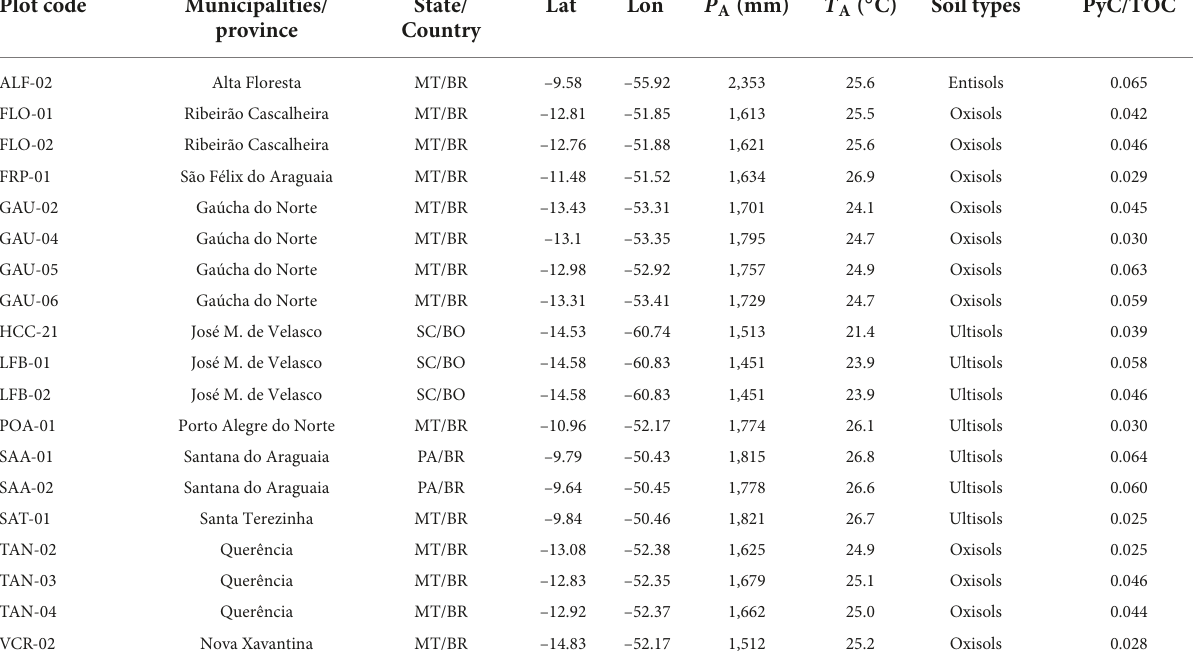
TABLE 1 Forest plot codes (RAINFOR codes), states (MT, Mato Grosso; PA, Pará; SC, Santa Cruz province), Country (BR, Brazil and BO, Bolivia), geographic location, annual precipitation ( P A ), average annual temperature ( T A ), soil types (Soil Survey Staff, 1999), and soil PyC/Total Organic Carbon (TOC) of areas sampled along the Amazon-Cerrado